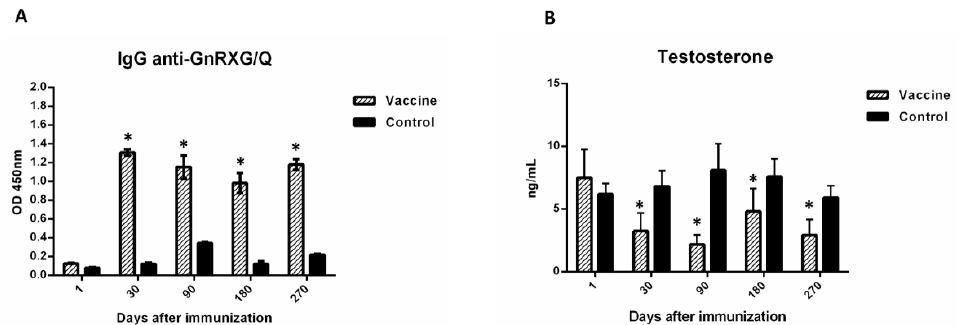
Figure 2. Vaccination induced the production of the specific IgG anti GnRXG/Q and decrease serum testosterone in controlled conditions. Dogs were inoculated on days 1 and 30 with the GnRXG/Q antigen and chitosan as adjuvant (Vaccine group, n = 7) or chitosan in absence of the antigen (Control group, n = 7). Vaccination induced the production of specific IgG anti GnRXG/Q ( A ) and a decrease in serum testosterone ( B ) from the first vaccination (day 30) to the end of the study. All data are represented as mean ± SEM. Asterisks (*) indicate significant differences in relation to day 0 ( p < 0.01).